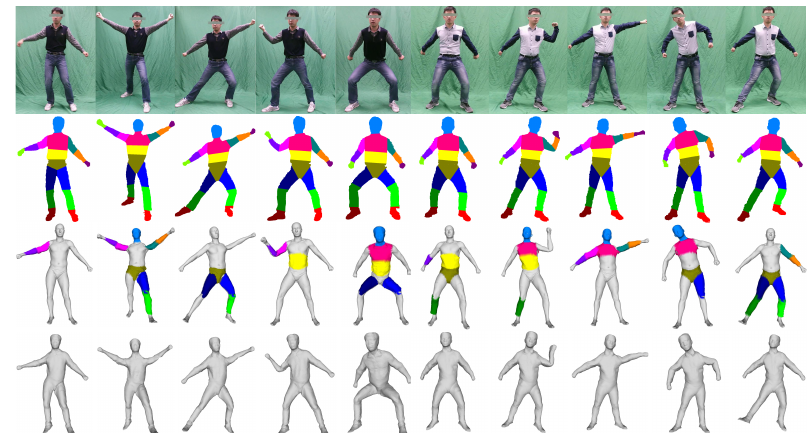
Figure 10. Some of the results. The first row shows some representative frames of our dataset. The second row shows the 2D kinematic classification. The third row shows the deformation of our template, the deformed parts are marked in different colors. The last row is the model driven by the current